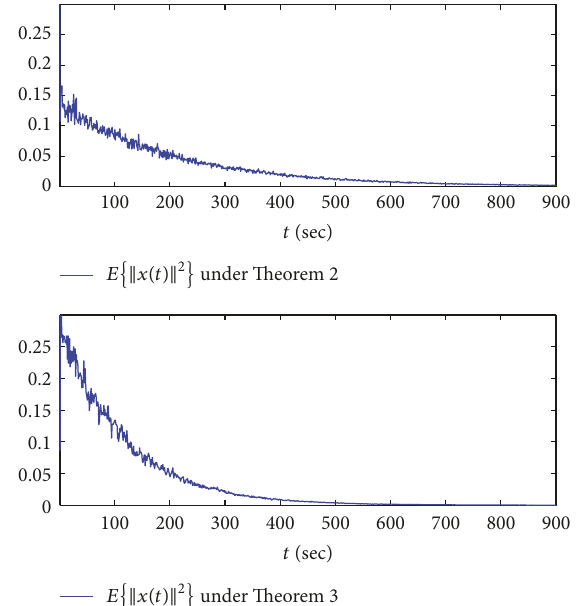
Figure 1: Comparison of mean square stability under different theorems.